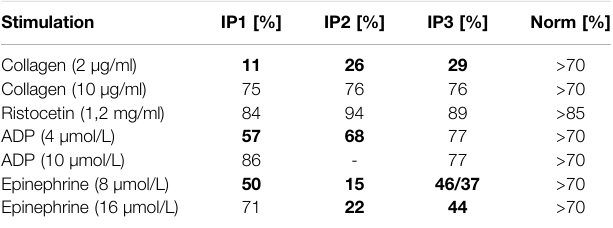
TABLE 1 | Platelet aggregometry analyses (LTA). Data are presented as maximal aggregation/agglutination in % compared to normal control